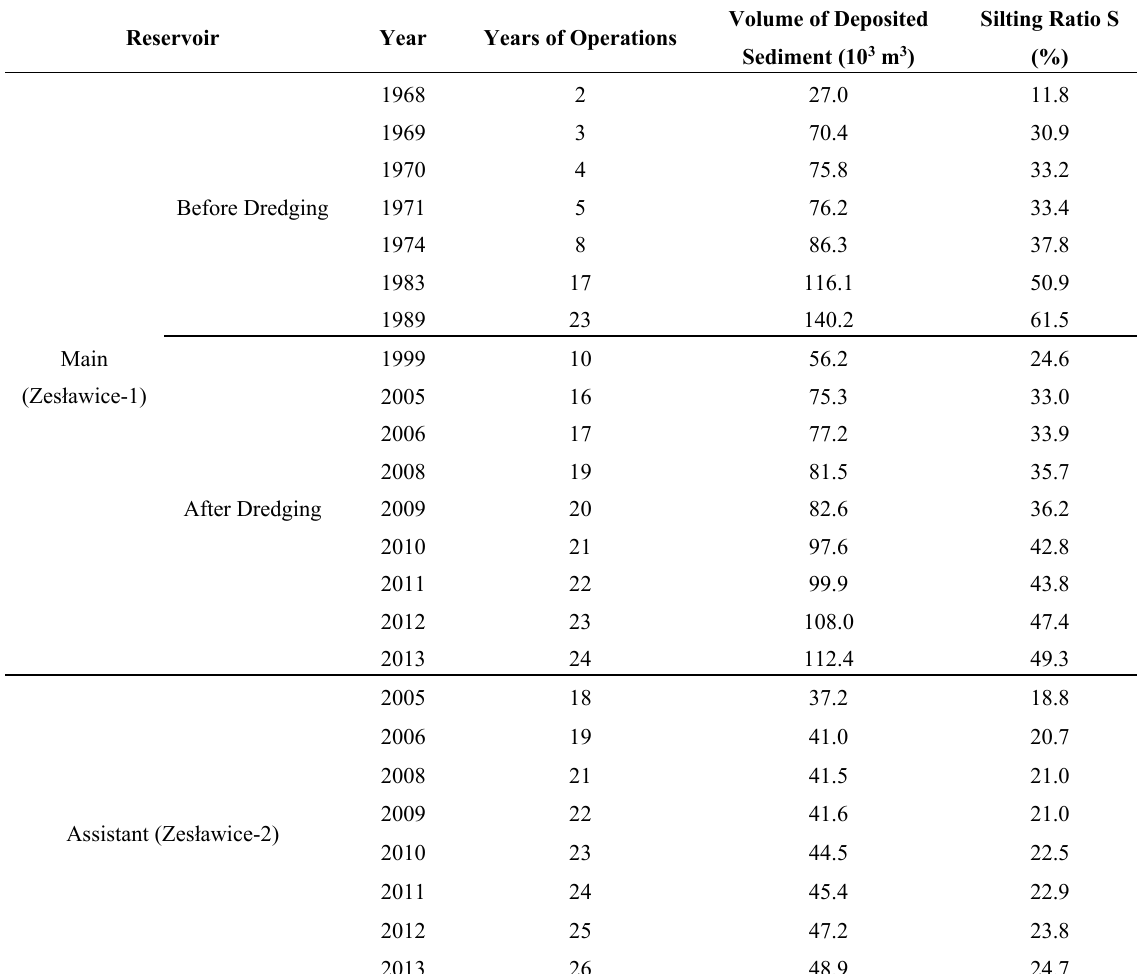
Table 3. The silting rate and volume of sediments deposited in main and assistant reservoirs at Zes ł